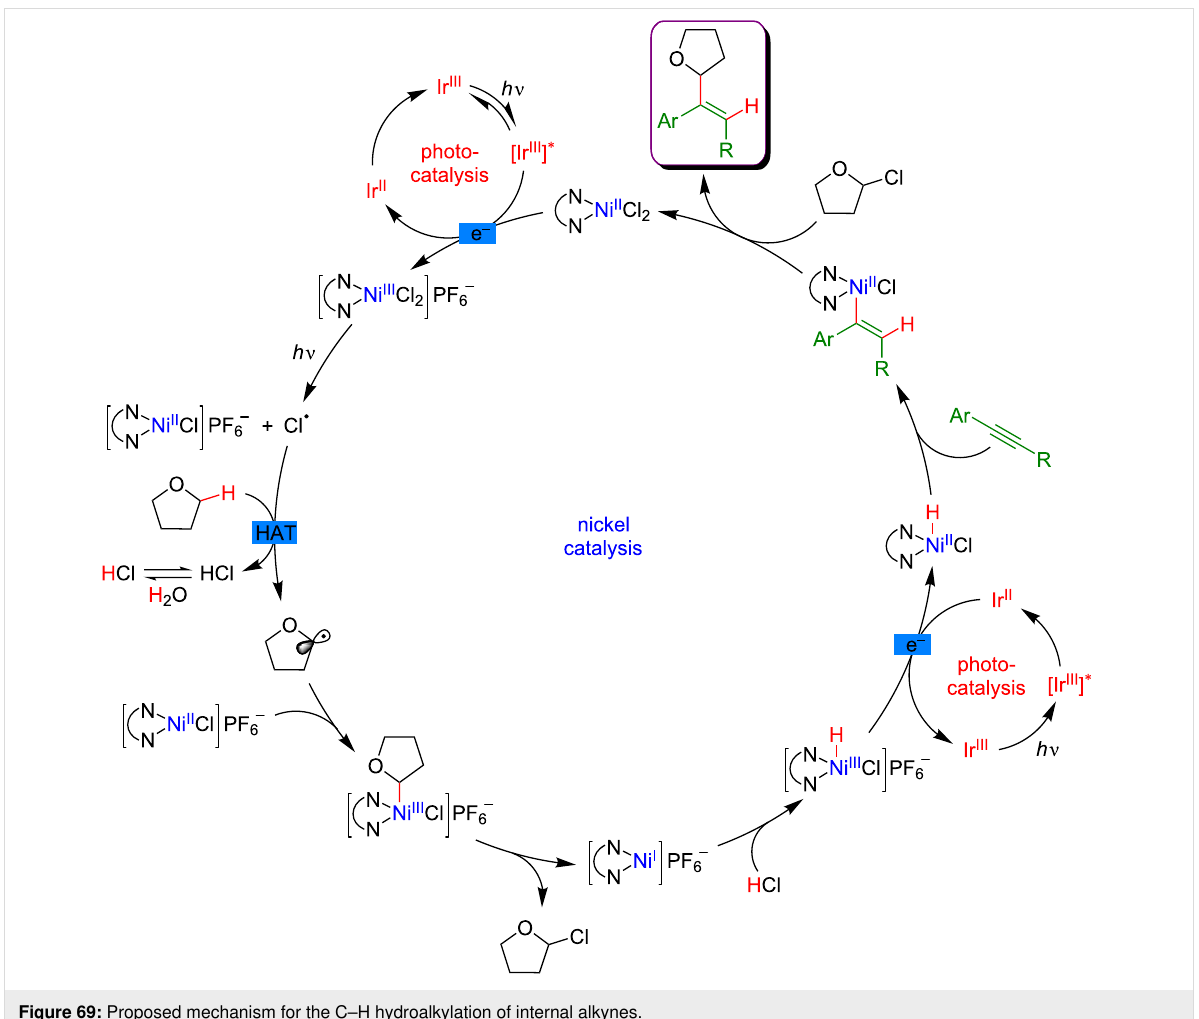
Figure 69: Proposed mechanism for the C–H hydroalkylation of internal alkynes.